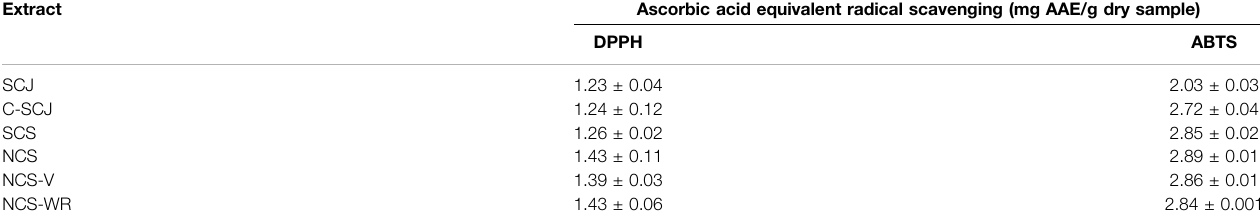
TABLE 2 | Ascorbic acid equivalent (AAE) scavenging of DPPH and ABTS radicals by sugarcane-derived extracts. Extract